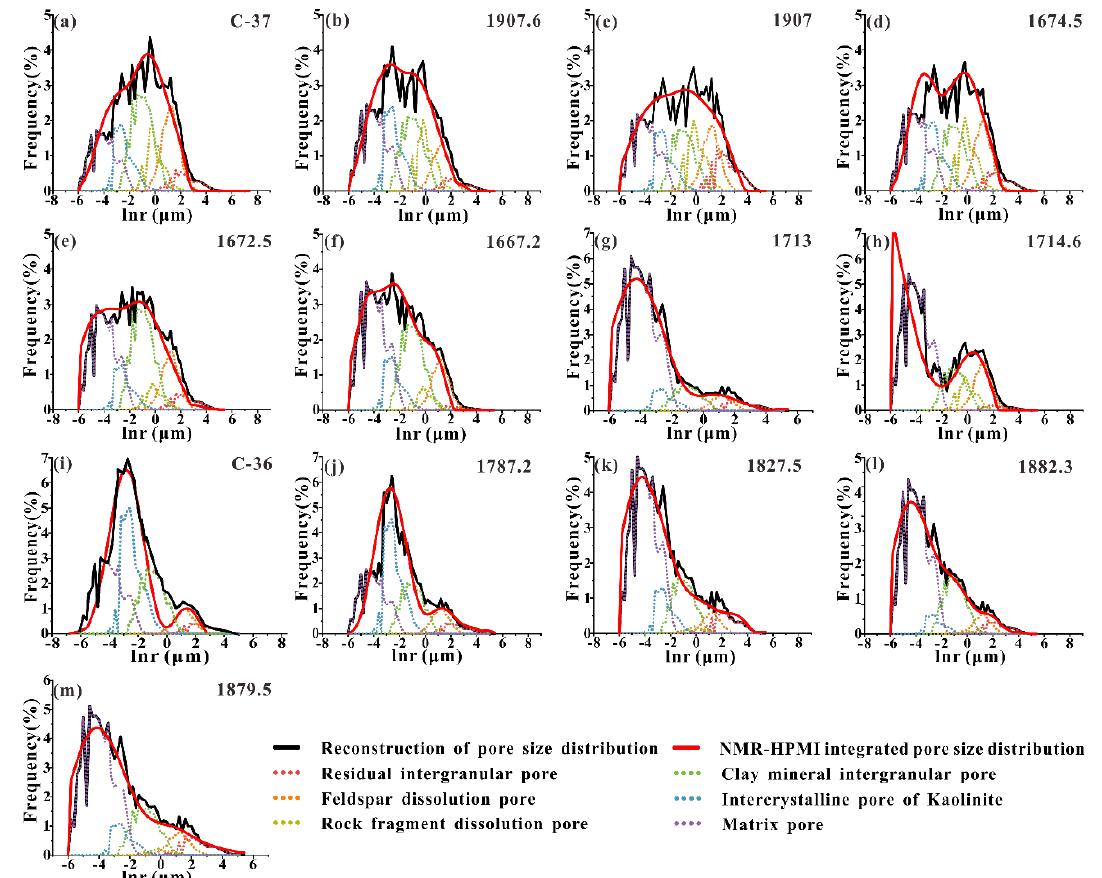
Figure 4. The results of decomposing the HPMI-NMR-derived PSDs using the least squares estimator for 13 J 1 b sandstone samples.